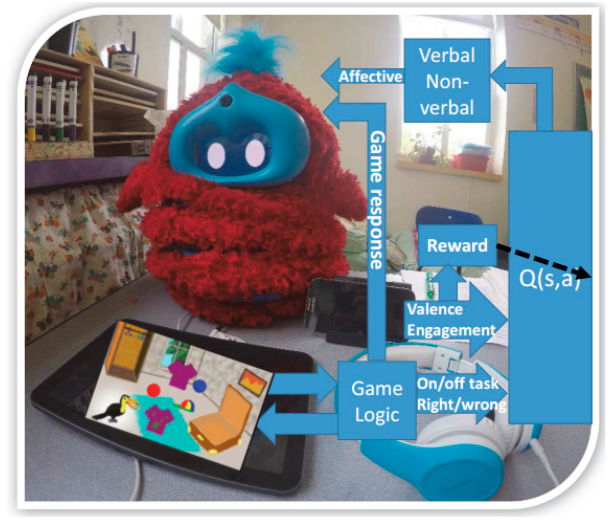
Figure 7. The implementation of the Tega system, including a tablet and a physical robot [72].